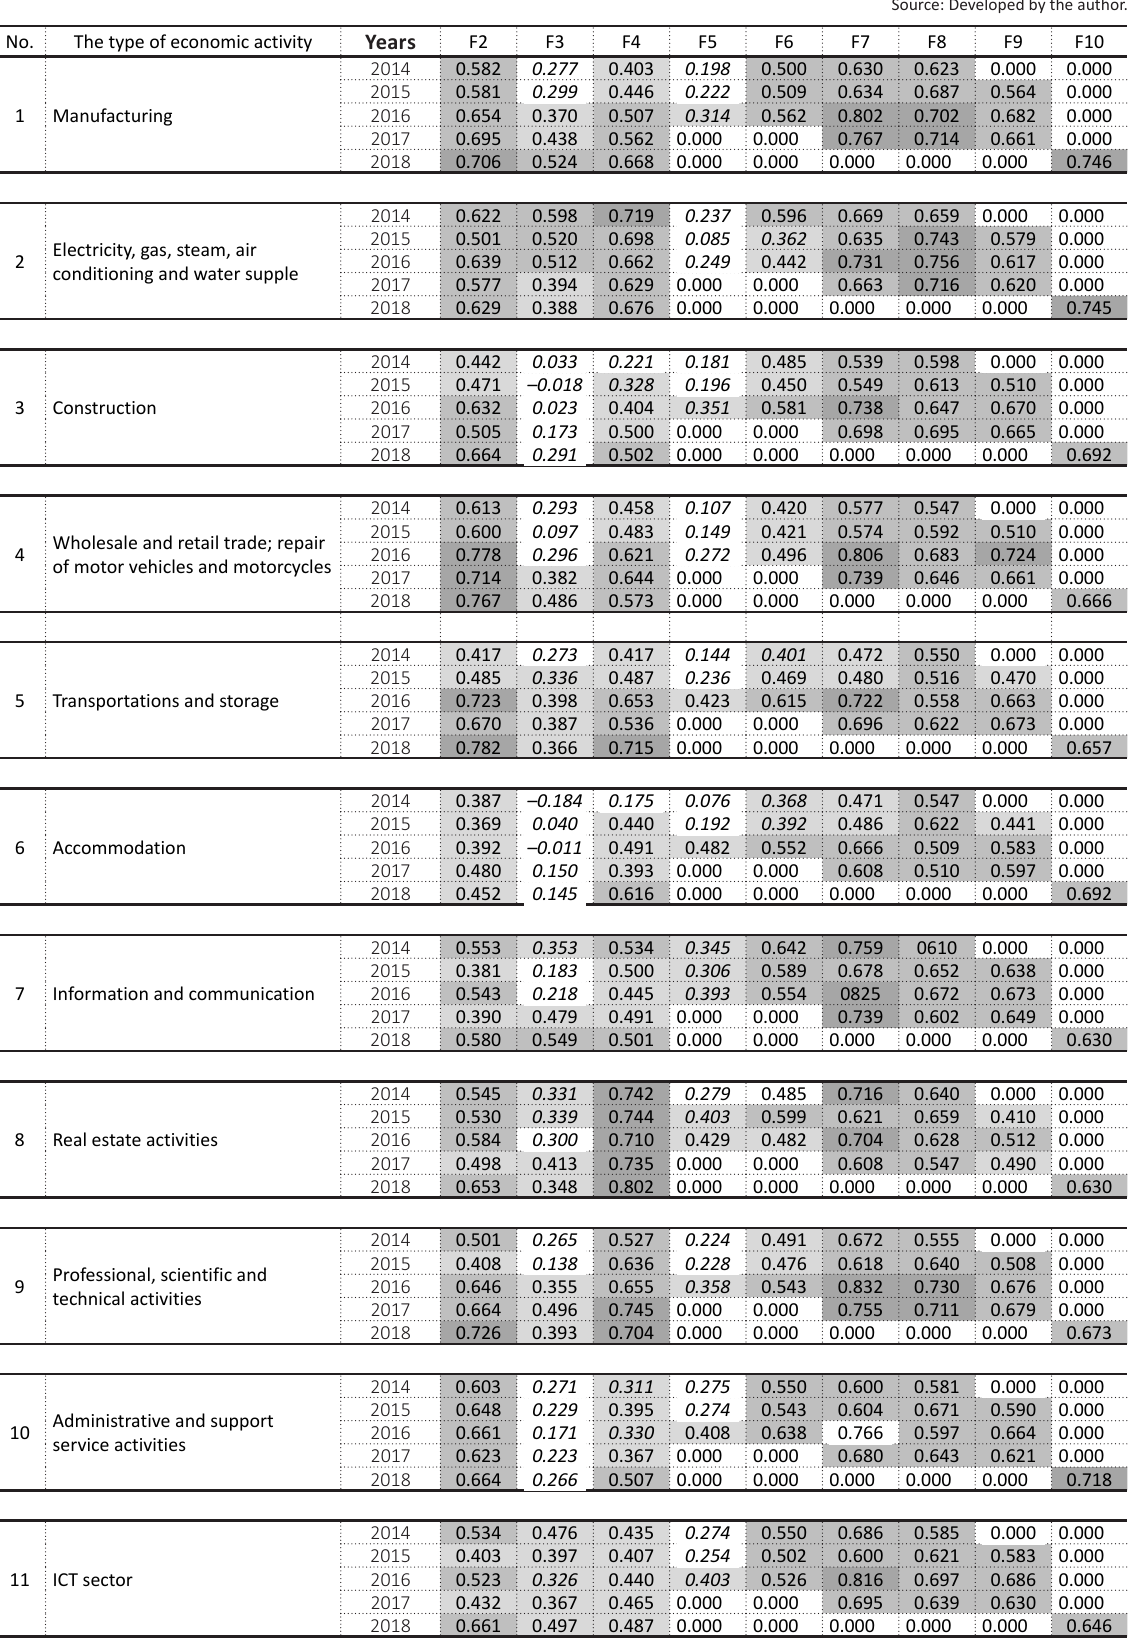
Table 3. Correlation analysis